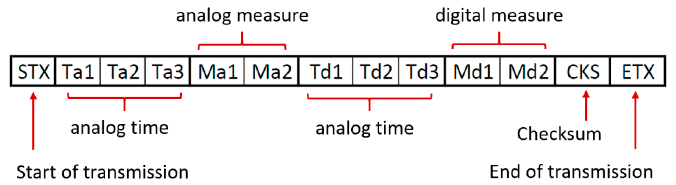
Figure 5. Example of a string of bytes containing the data of an analog sensor, a digital sensor of one variable, and the checksum byte. The time resolution has been set to 3 bytes (24 bits) for both sensors.